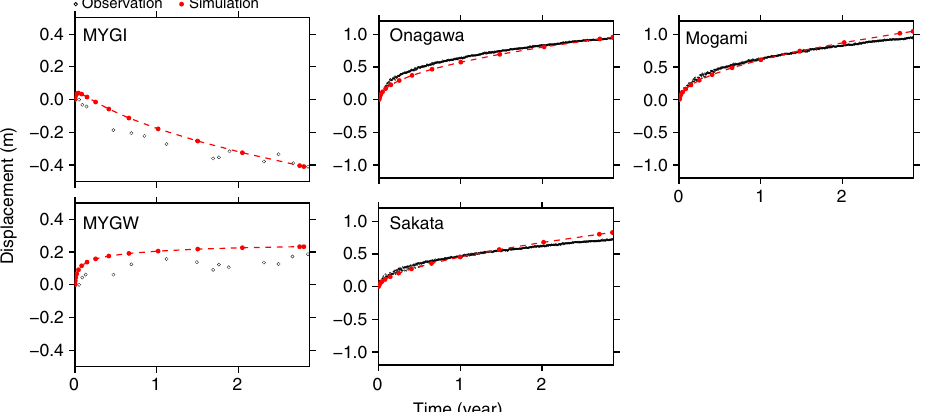
Fig. 6 The displacement time series in the trench-perpendicular direction at the stations denoted by the orange circles in Fig. 4a. Relatively large mis fi t in the station MYGW is discussed in the main text